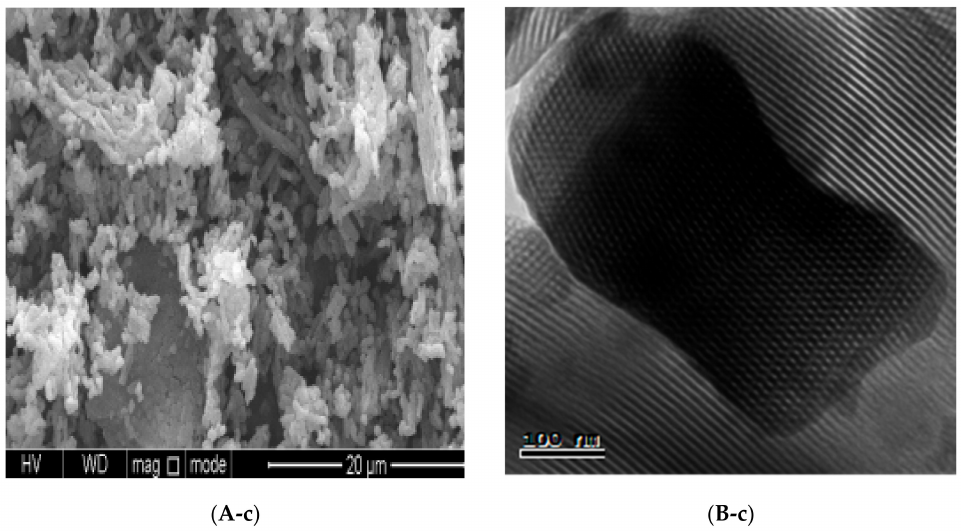
Figure 2. Scanning electron microscopy (SEM ( A ) and transmission electron microscopy (TEM) ( B ) of mesoporous SBA-15 ( a ); H-SBA-15-SH ( b ); G-SBA-15-SH ( c